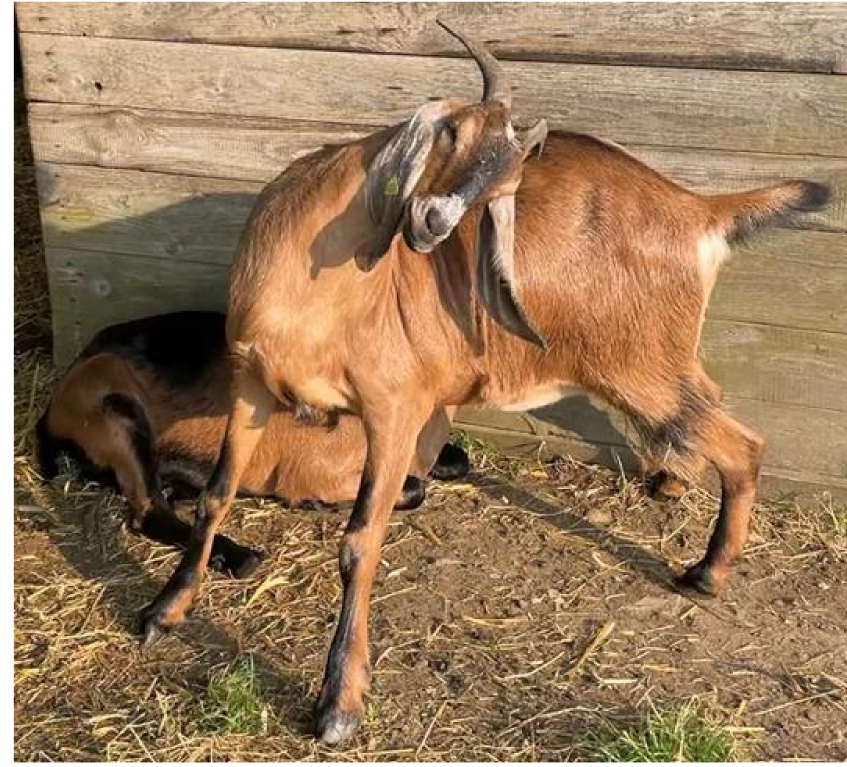
Figure 1. Anglo Nubian goat scratching its back with the horn